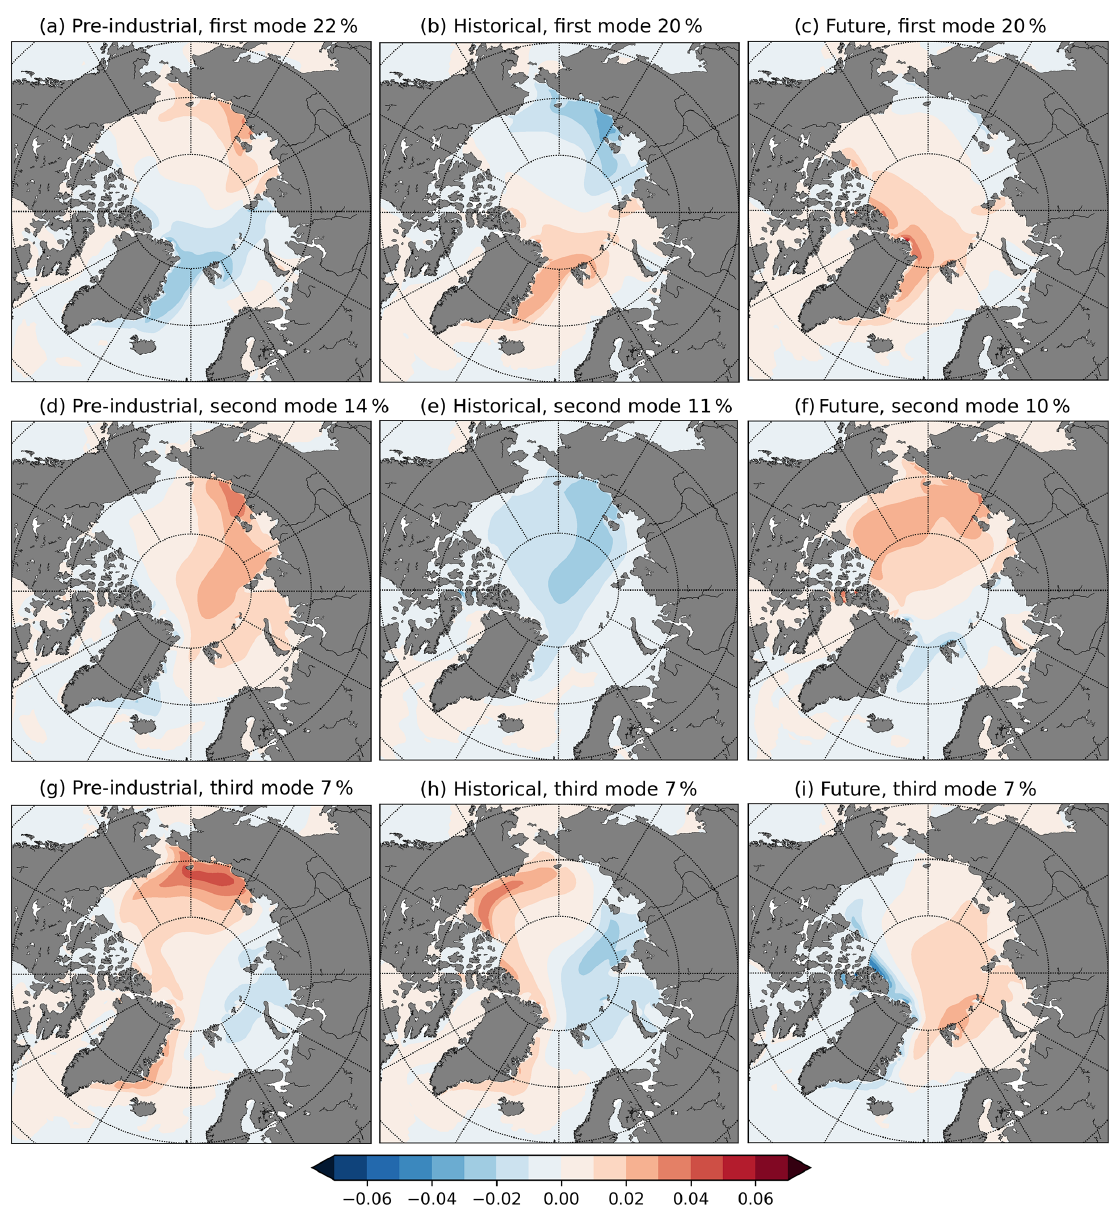
Figure 2. Modes of Arctic SIT spatial variability. From the left to the right, each row shows the first three EOFs of Arctic SIT over the pre- industrial (200 years preceding the historical integration) (a, d, g) , historical (1920–2005) (b, e, h) and future (2006–2050) (c, f, i) periods, respectively. EOFs for the historical and future periods are performed over 30 ensemble